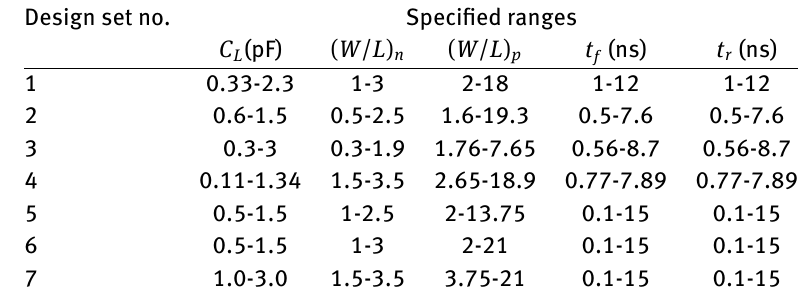
Table 4: Delay limits and design parameters bound for the Case study-2. Design set no.